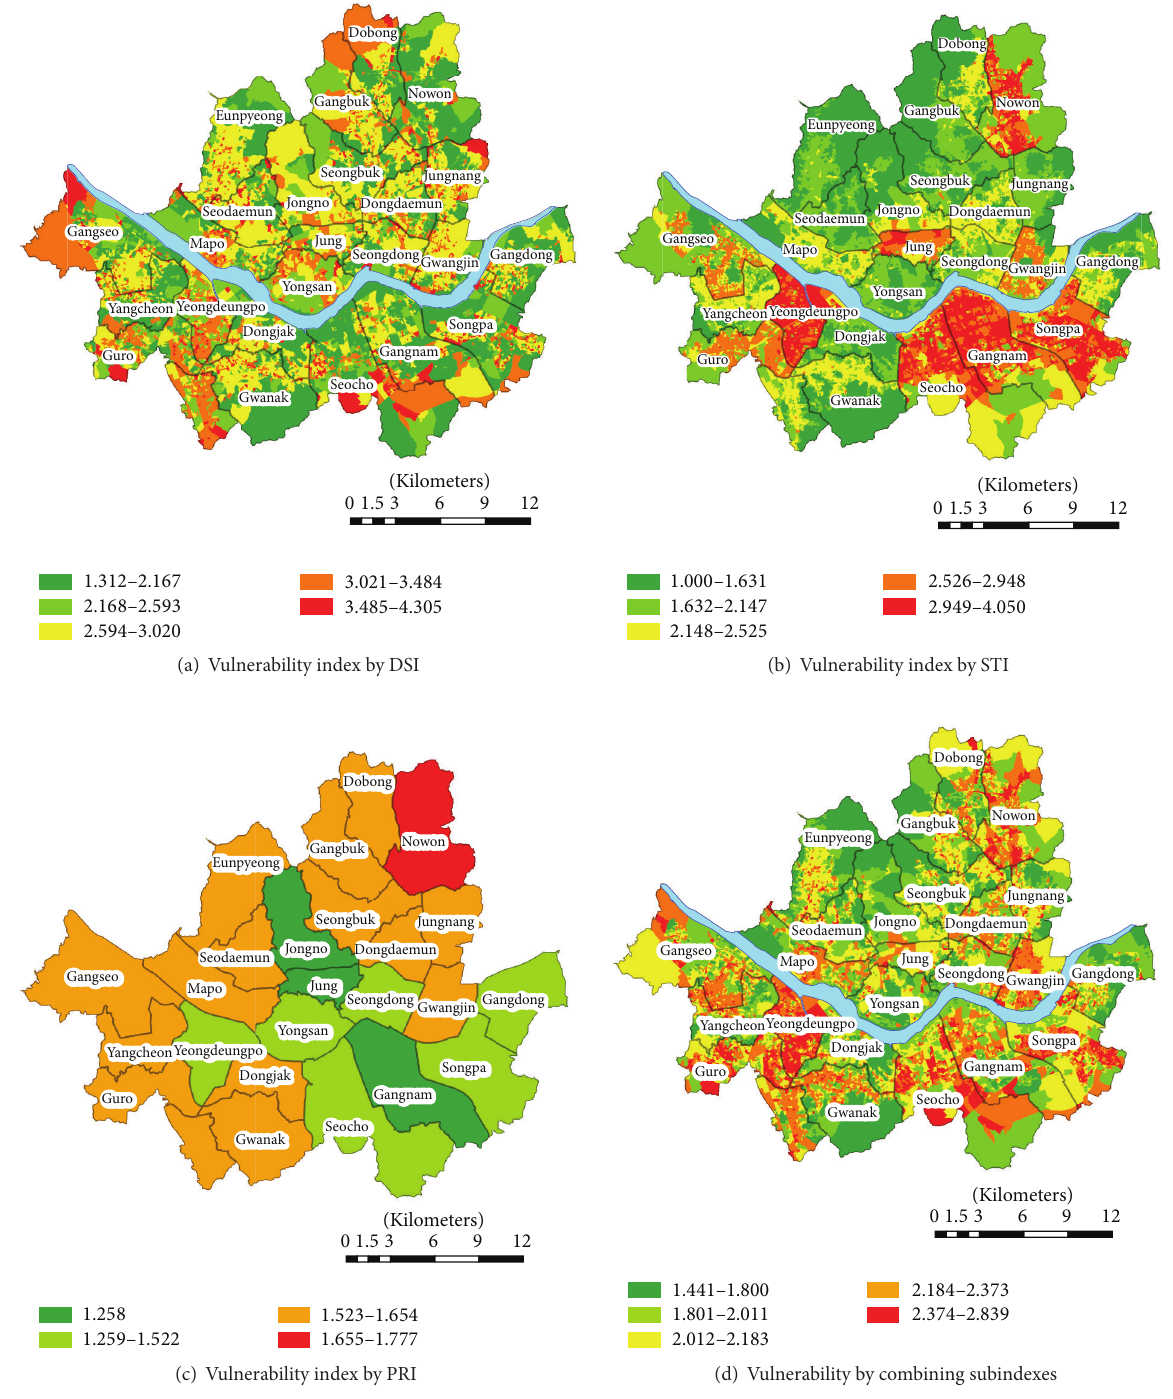
Figure 8: Result of socioeconomic vulnerability